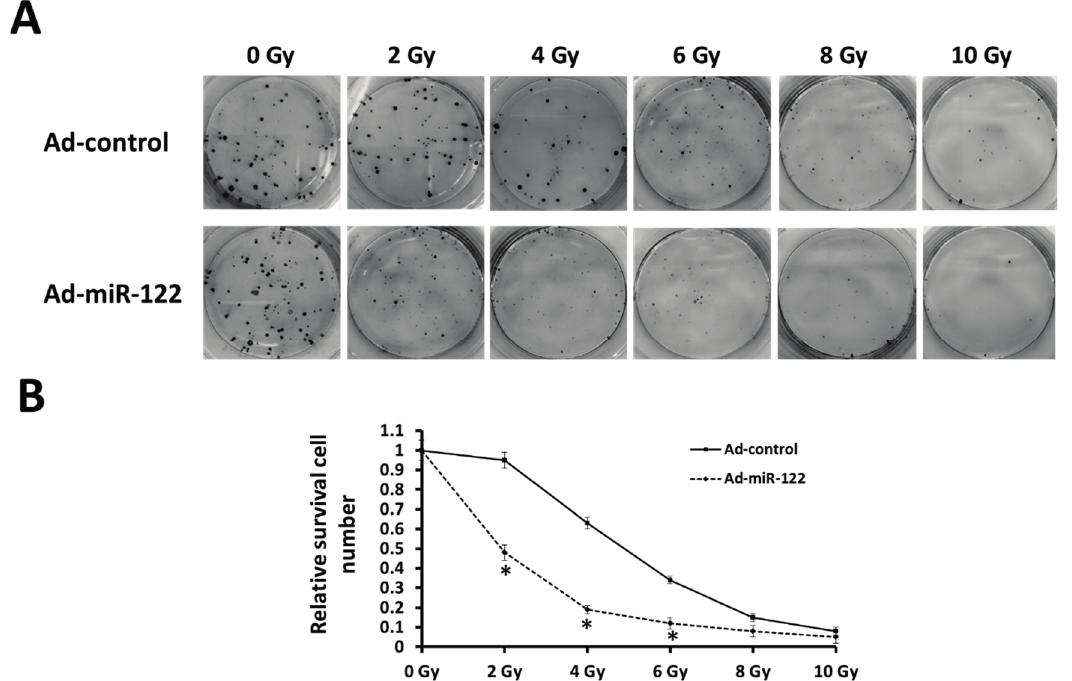
Figure 2. MiR-122 enhances the radiosensitization of A549 cells. ( A ) A549 cells, which were infected with Ad-control or Ad-miR-122, then treated with indicated dose (0, 2, 4, 6, 8 or 10 Gy) of 60 Co- γ IR (ionizing radiation). Then, cells (1 × 10 3 cells per well) were seeded in 6-well plates (Corning, Lowell, MA, USA) and cultured for 2–4 weeks, and the colonies were detected by staining with crystal violet (0.5% in 20% ethanol). Next, cells were harvested and measured by a multifunctional micro-plate reader at 546 nm. The results were shown as a typical photograph ( A ) or relative survival cell number (mean ± SD) from triplicate experiment with similar results ( B ). * p < 0.05 versus Ad-control or